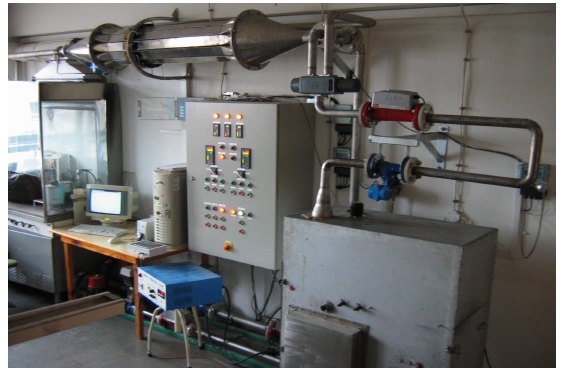
Fig. 1. Research equipment for toxic combustion products emit-